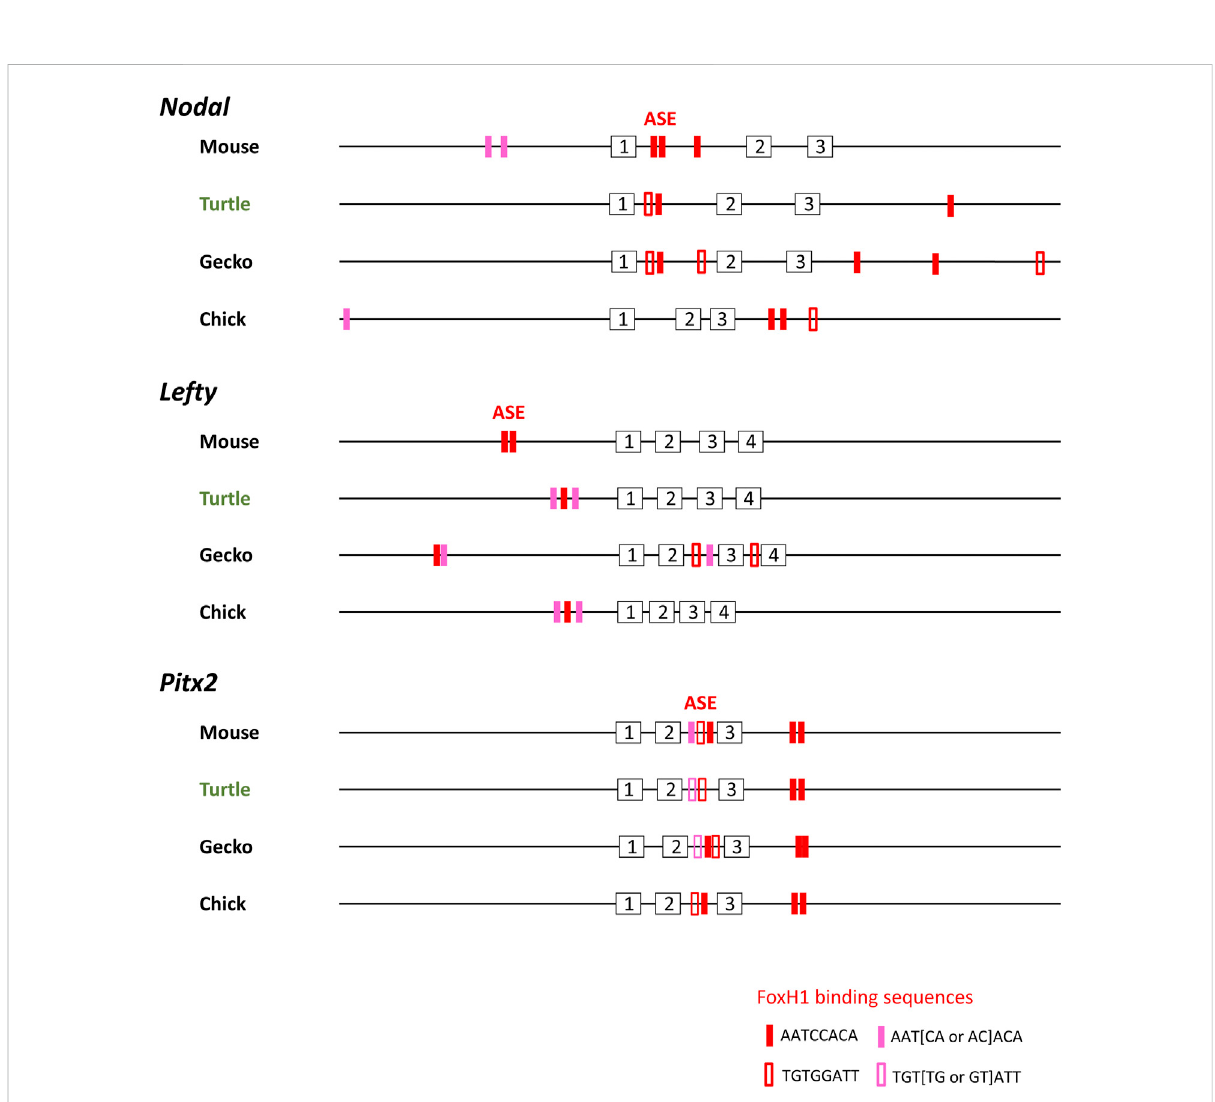
FIGURE 4 Transcriptionalenhancer (ASE) sequences of Nodal , Lefty , and Pitx2 genes ofamniotes.FoxH1-binding sequences (red and pink boxes) present within a 30-kbp region of Nodal , Lefty , and Pitx2 genes of mouse ( Mus musculus ), reptiles, and chicken ( Gallus ) are shown. Analysis of Nodal genes was previously performed (Kajikawa et al., 2020). For mouse, which has two Lefty genes, Lefty2 is shown. Red closed and open boxes correspond to AATCCACA and TGTGGATT, respectively. Pink closed and open boxes denote ATT [AC or CA]ACA and TGT [GT or TG]ATT, respectively. Numbered boxes indicate exons. Turtle and gecko refer to the Chinese softshell turtle ( Pelodiscus sinensis ) and Madagascar ground gecko ( Paroedura picta ), respectively. Nodal , Lefty , and Pitx2 genes of other turtles (green sea turtle and painted turtle) show similar con fi